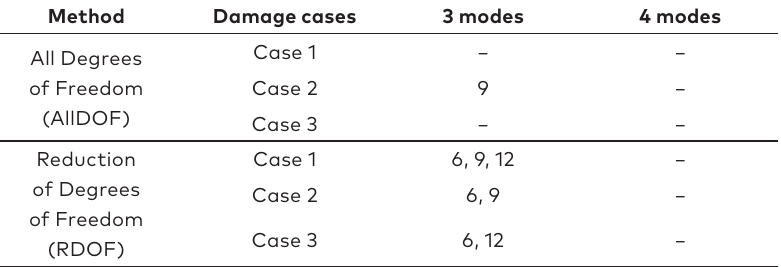
Table 3. False elements identified for the 15-element